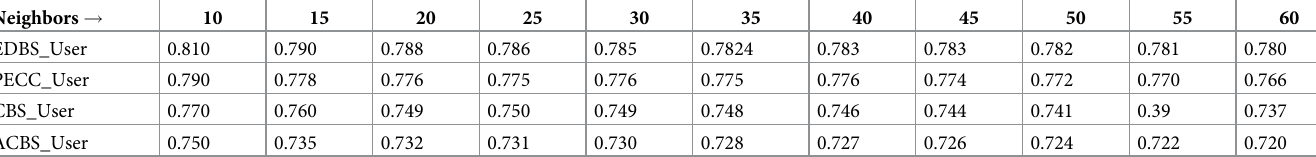
Table 4. MAE values of different similarity methods as value of neighbors